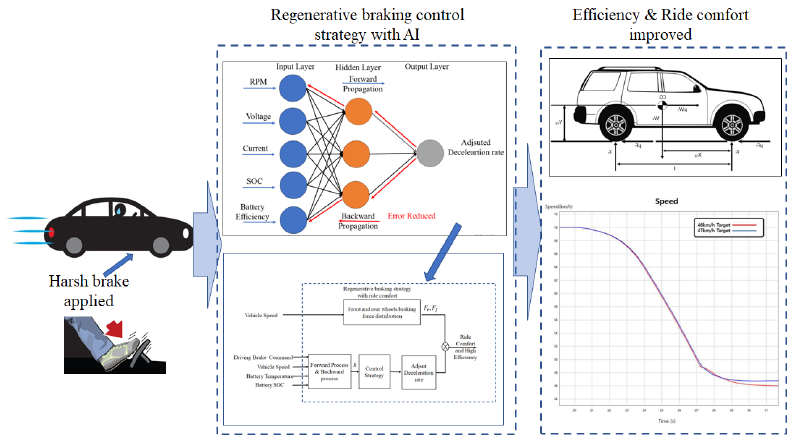
Figure 4. Regenerative braking control strategy with CRBS method.